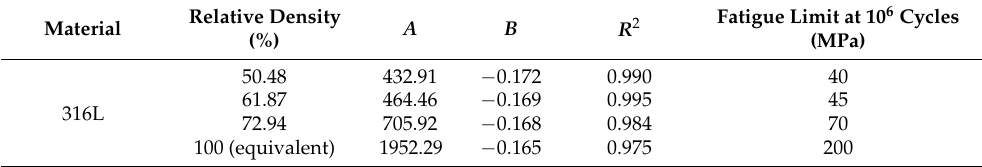
Table 5. The constants from linear fittings and fatigue limit of the 316L specimens.